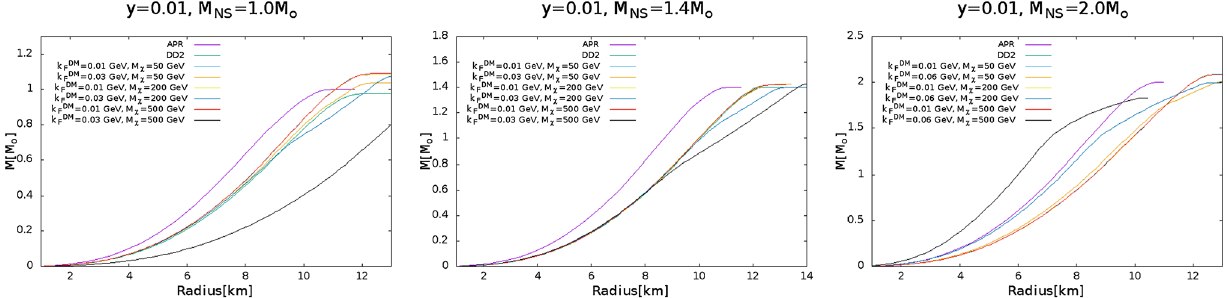
respectively. Here, the chemical potentials μ e and μ μ